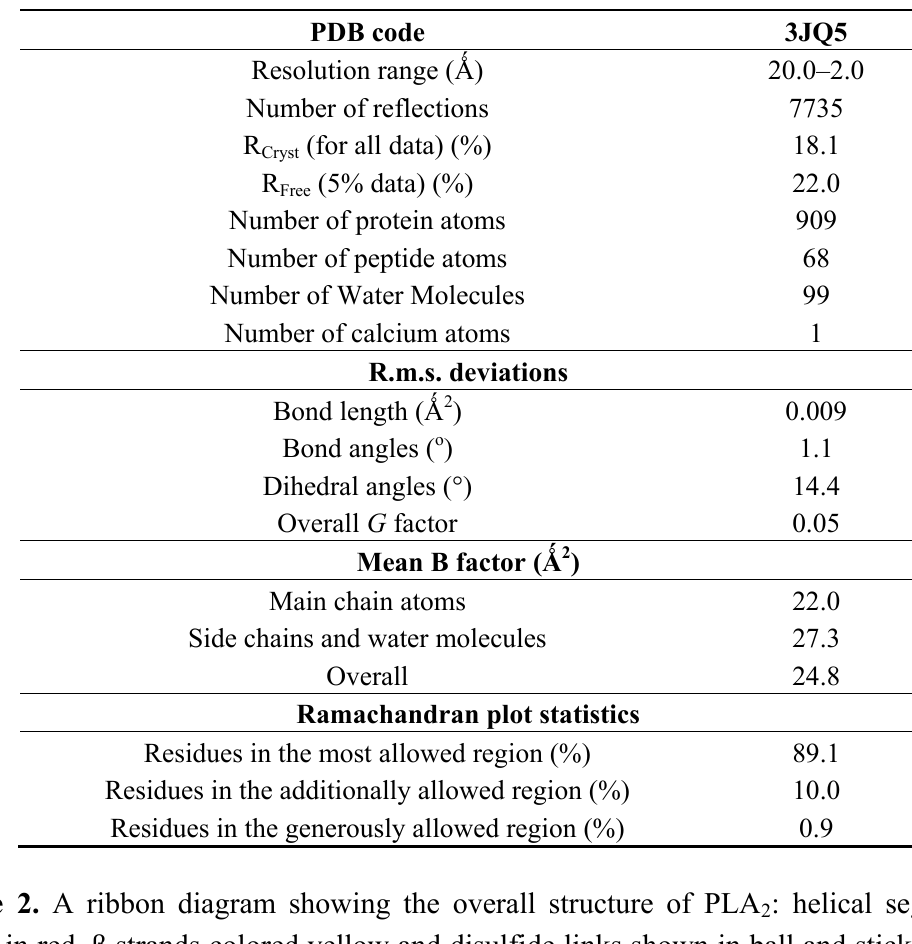
Table 2. Refinement statistics.